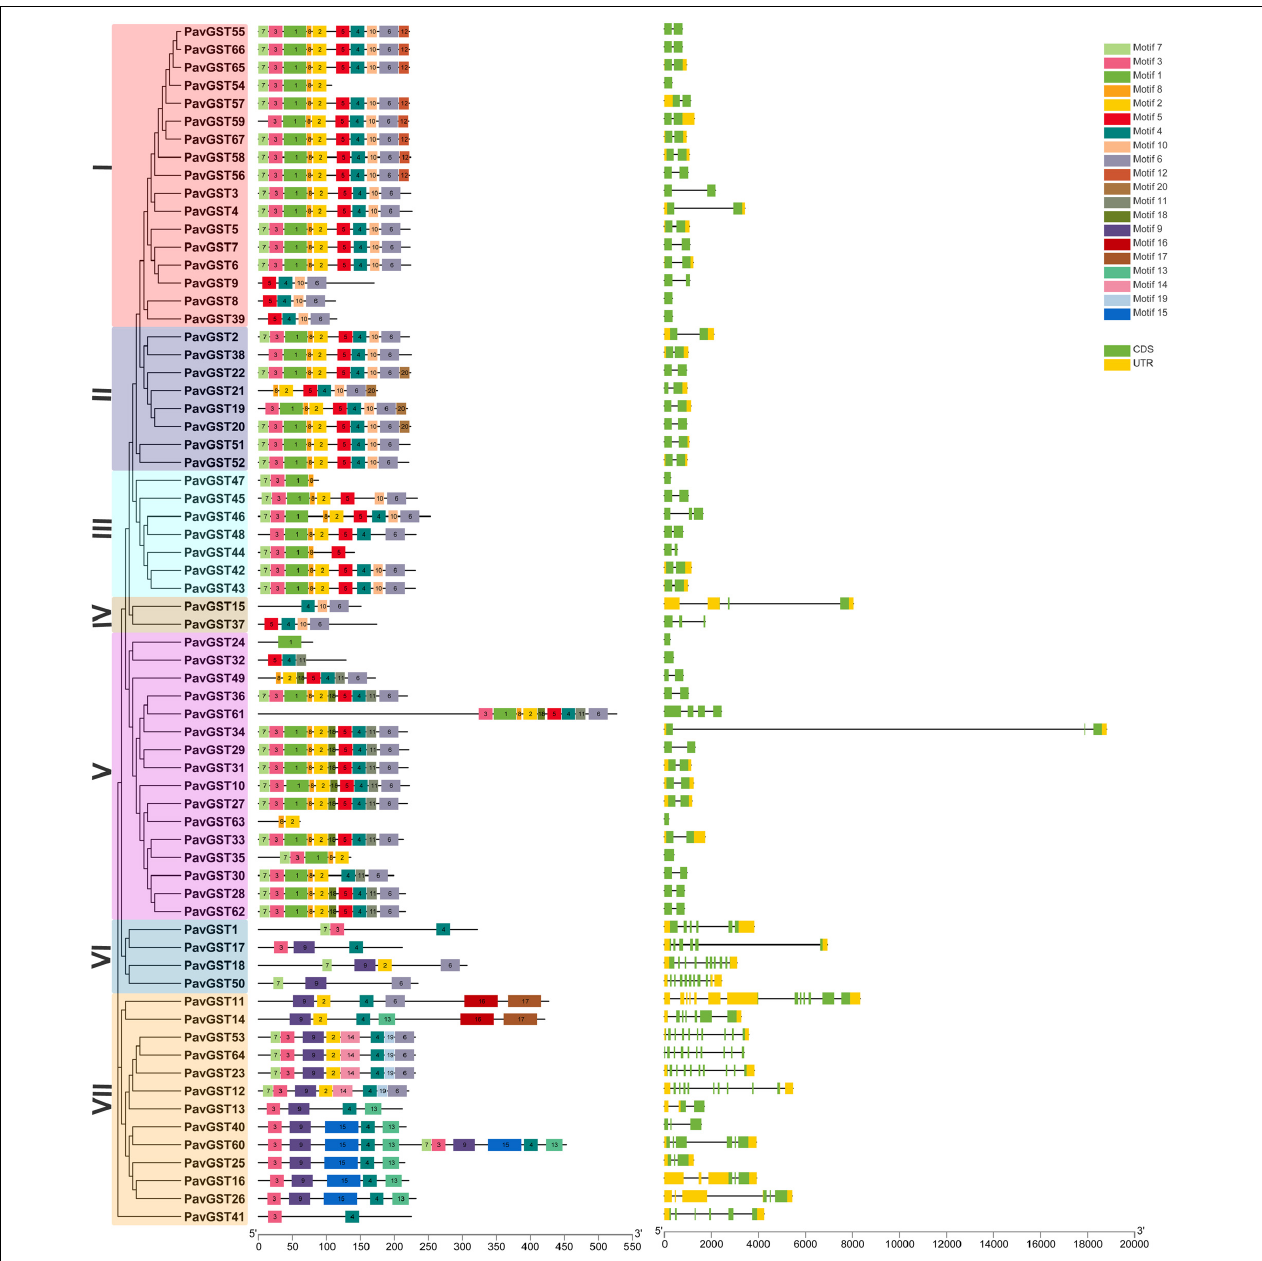
FIGURE 2 | Phylogeny (left panel), conserved motifs (center panel) and intron-exons (right panel) for GST family proteins in sweet cherry were analyzed. (A) The motif composition of PavGST protein (1–20) is represented by distinct colored boxes with appropriate motif numbers and figure legends are mentioned on the top. (B) Phylogeny and gene structure for GST family proteins in sweet cherry. The relative position and size of the exon can be estimated using the scale at the bottom. Green boxes, black lines, and yellow boxes illustrated exons, introns, and UTR,